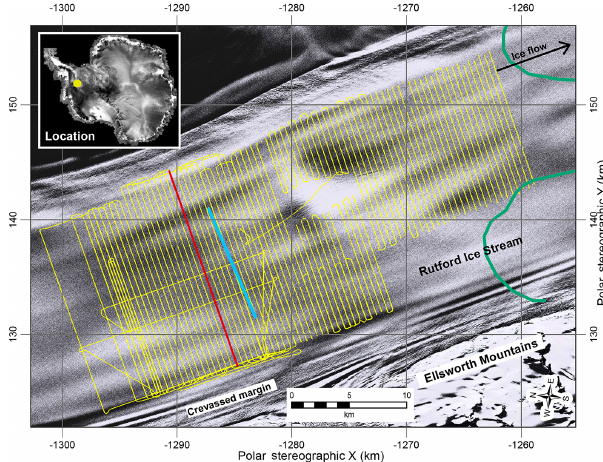
Figure 1. Location map. Rutford Ice Stream flows towards the south-east past the Ellsworth Mountains at between 365 and 400ma − 1 . Radar survey lines shown in yellow. Lines are spaced 500m apart. Gaps in the coverage are due either to equipment fail- ure or the need to avoid crevasses. The grounding line is shown in green. Location of profile line shown in Fig. 2 marked in red. Loca- tion of line C1 from Smith and Murray (2009) shown in blue. Polar stereographic projection. Axes are kilometres from South